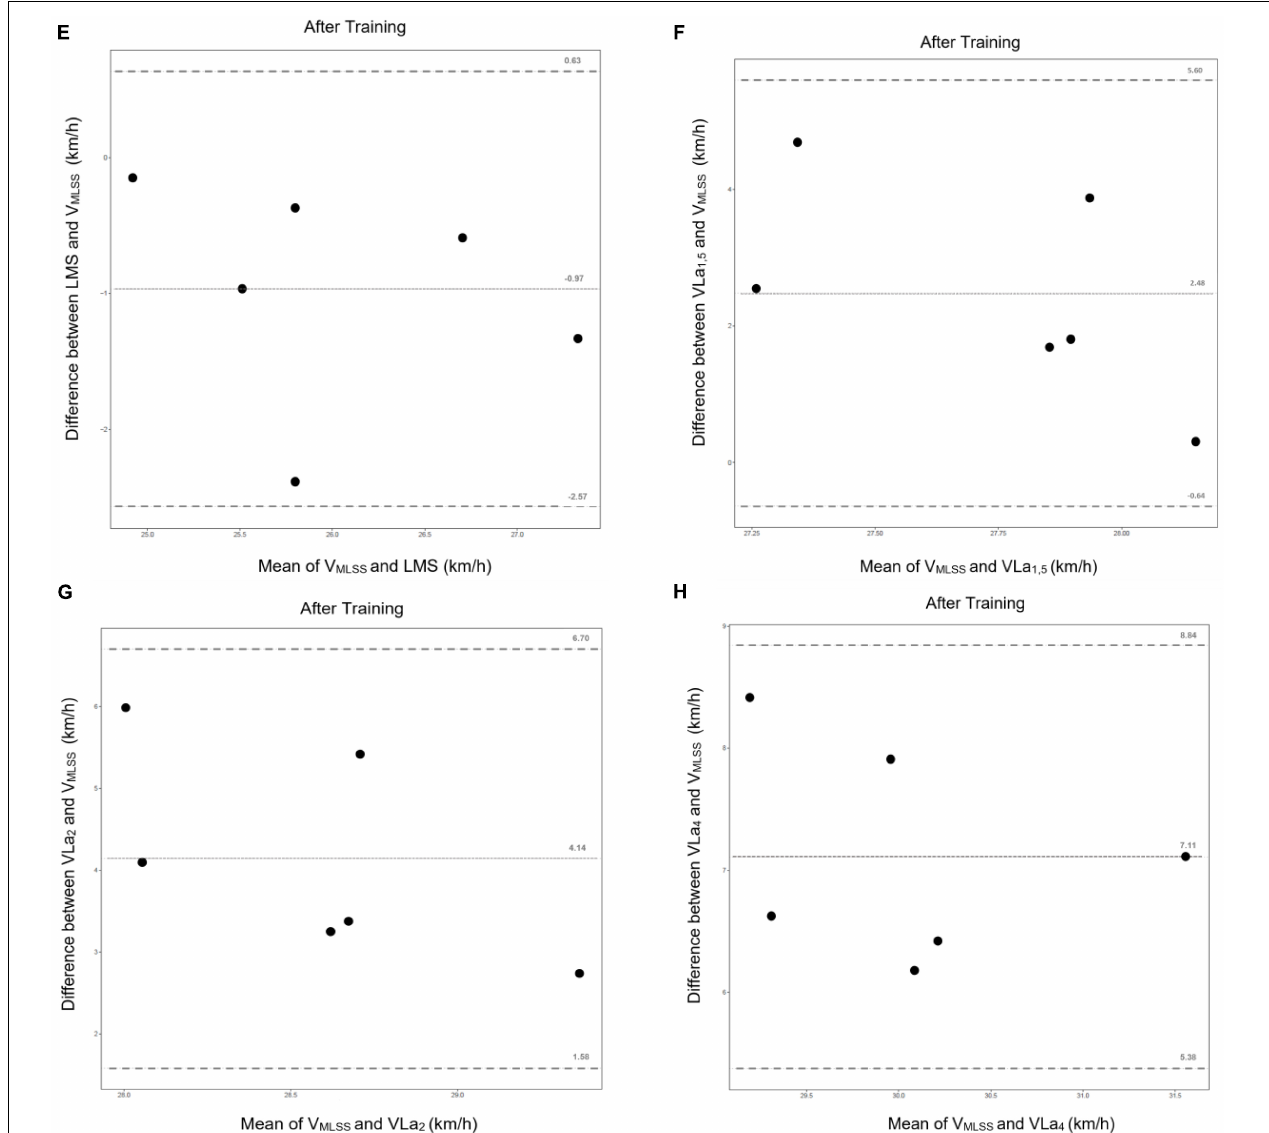
FIGURE 6 | Bland-Altman plots with the mean bias and the 95% agreement CI for comparison between velocities of the MLSS vs. LMS (A,E) , VLa 1 , 5 (B,F) , VLa 2 (C,G) , and VLa 4 (D,H) with (A–D) before the 8 weeks of training and (E–H) after 8 weeks of training. For each plot: the dotted line in the centre represents the mean bias and the upper and lower dotted line delimit of the 95% limits of agreement for the mean bias.